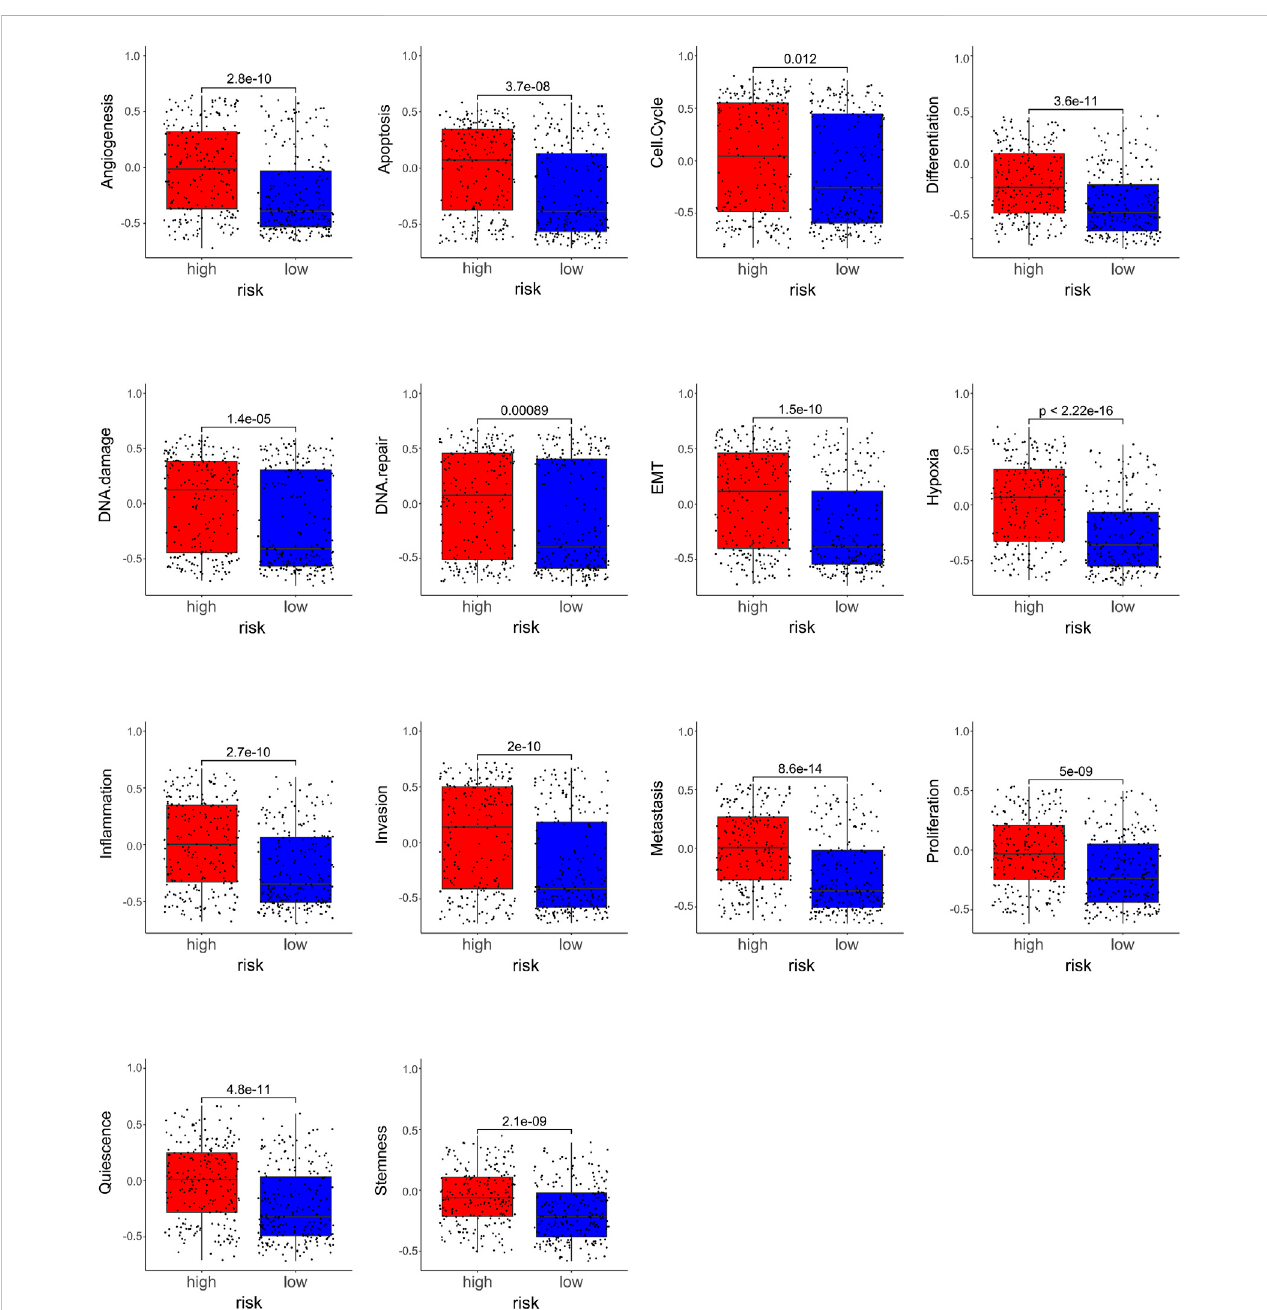
FIGURE 4 Relationships between the compositions of the risk scores and the tumor